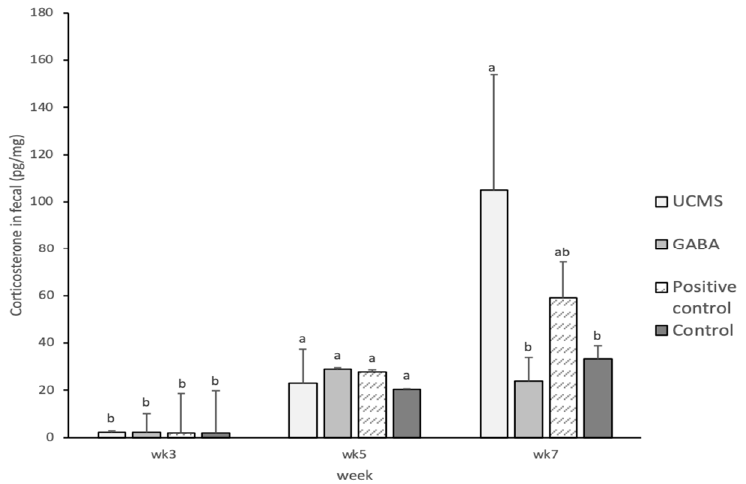
Figure 6. Effect of GABA feed by vegetable soybean on corticosterone content in mice fecal (CORT). Data are represented as mean ±SD. Group with different letter superscripts are significantly different ( p < 0.05).